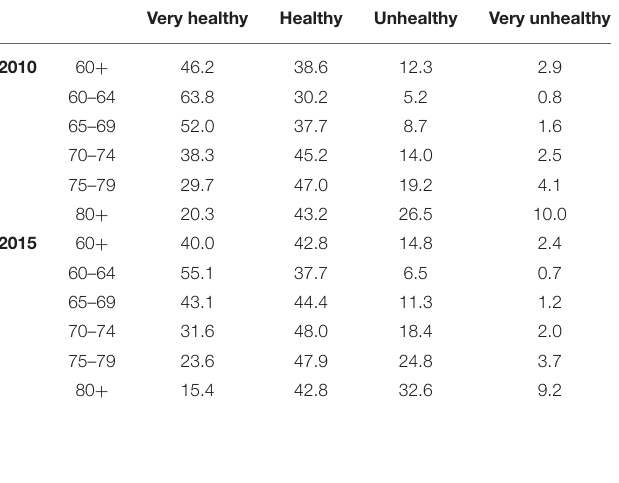
TABLE 2 | Percentage distribution of self–rated health by age and survey years. Very healthy